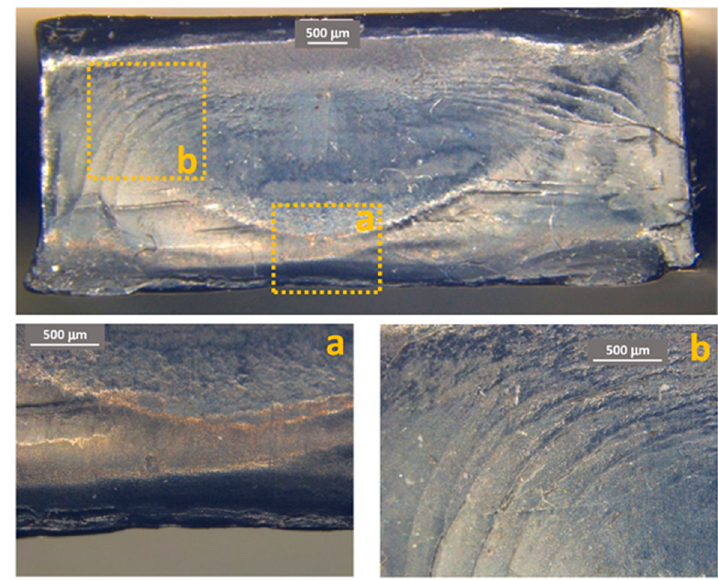
Figure 14. ABS fracture surface after test at room temperature. ( a ) Crack initiation point; ( b ) propagation beach marks.